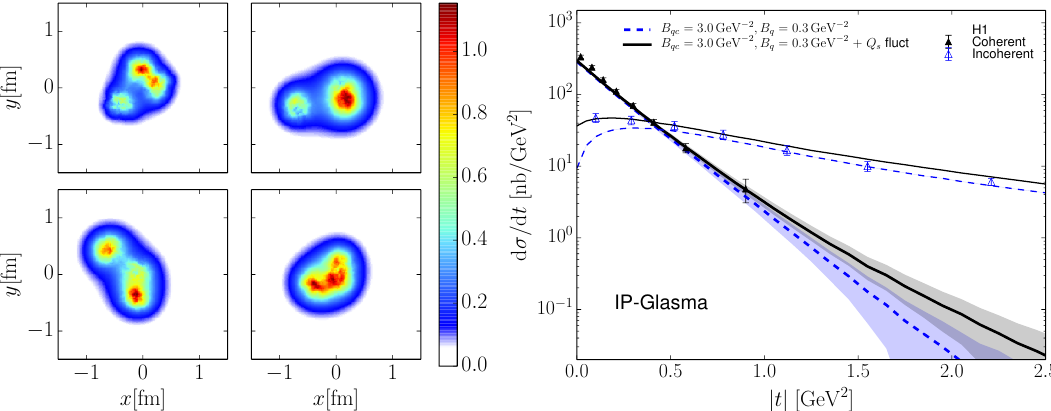
Figure 18. ( Left ) Color charge density for four different events. ( Right ) Coherent and incoherent H1 data compared to predictions from CGC incorporating sub-nucleonic (and Q s saturation